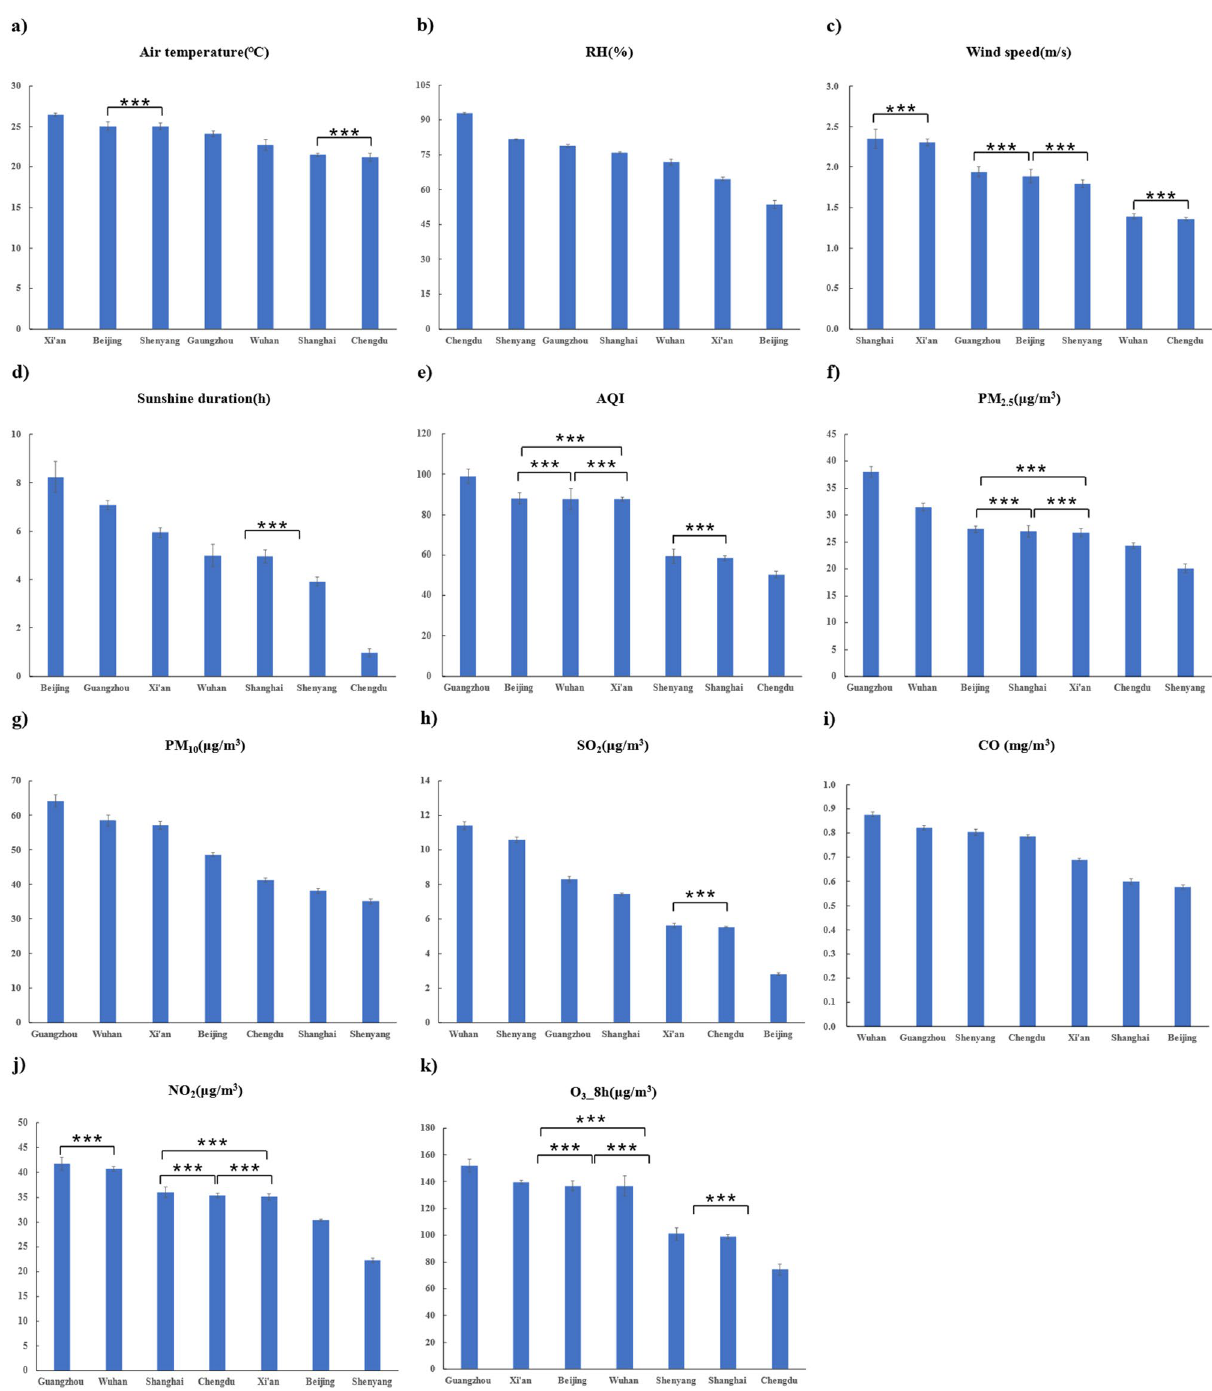
Figure 4. Comparison of environmental factors and air pollution indicators in seven cities. Air temperature ( a ); relative air humidity (RH) ( b ); wind speed ( c ). Sunshine duration ( d ); AQI ( e ); PM 2.5 values ( f ); PM 10 values ( g ); SO 2 values ( h ); CO values ( i ); NO 2 values ( j ); O 3 _8 h values ( k ). **Indicates a significant difference between the two cities ( P < 0.05). ***Indicates no significant difference between the two cities ( P > 0.05). Figure without ** or ***indicates a significant difference between two